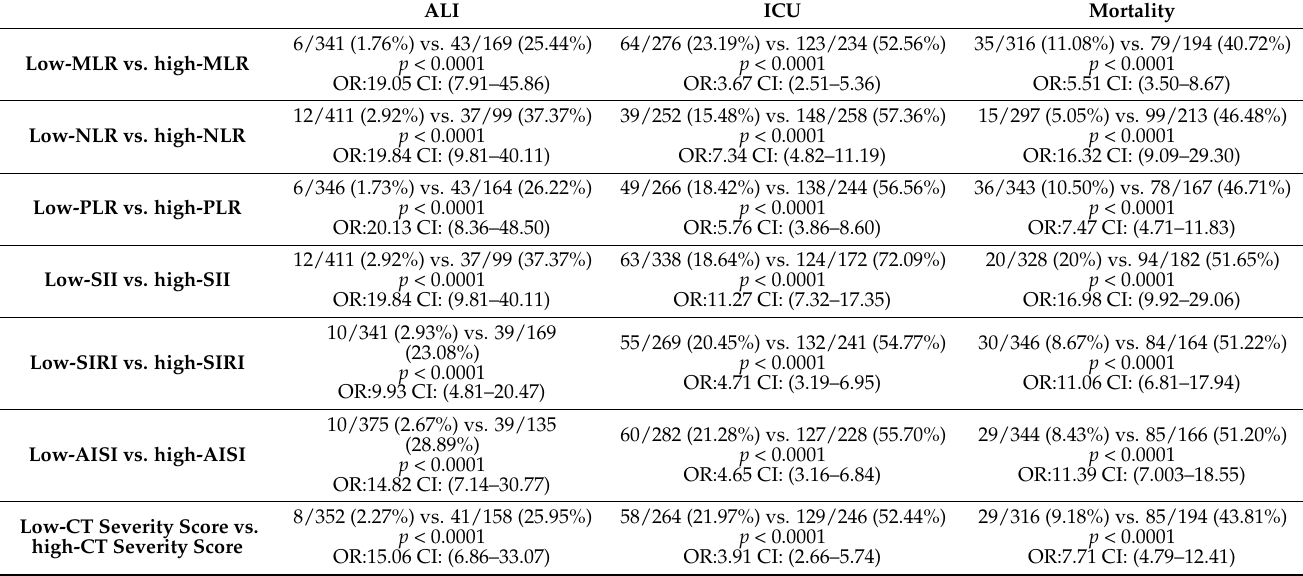
Figure 4. ROC curve analysis for the CT Severity Score ( A ) concerning the ALI risk (AUC: 0.725; p < 0.0001), ( B ) concerning the ICU admission (AUC: 0.733; p < 0.0001), and ( C ) concerning the mortality rate (AUC: 0.816; p < 0.0001). Table 4. Univariate analysis of MLR, NLR, PLR, SII, SIRI, AISI, and the CT Severity Score and all patients’ adverse event occurrences during the study period. ALI ICU